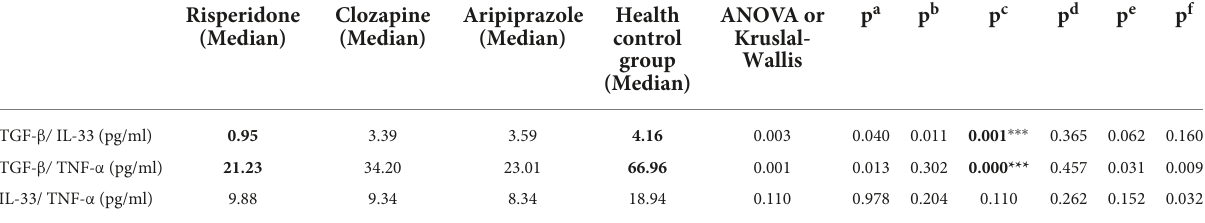
TABLE 7 Comparison of cytokines ratio according to all examined